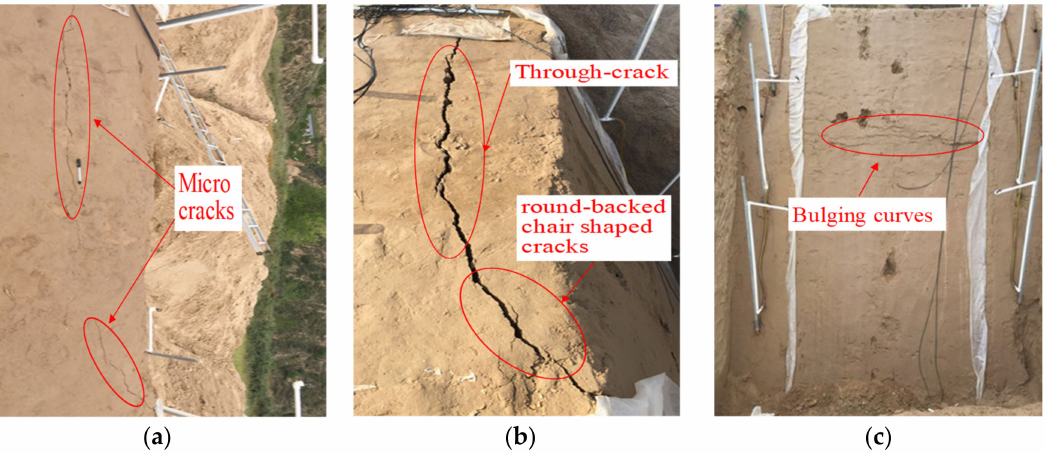
Figure 6. Cracks of the slope under heavy rainfall: ( a ) microcrack growth; ( b ) transverse penetration of crack at the slope crest; ( c ) bulging curves at the slope surface.